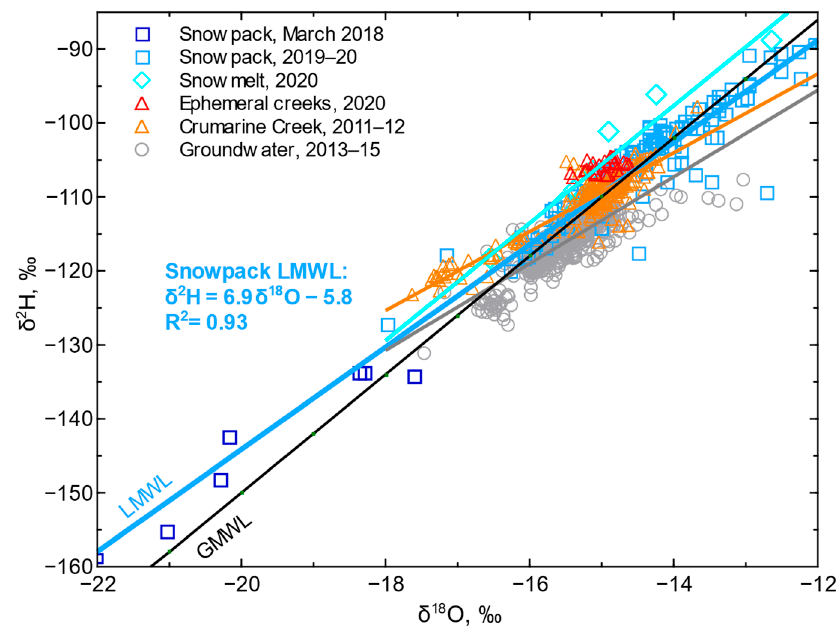
Figure 11. δ 2 H and δ 18 O for snow, snowmelt, ephemeral creeks, Crumarine Creek, and groundwater in the South Fork Palouse River Basin. The colored trendlines indicate the local meteoric water line (LMWL) for the potential source waters. The Global Meteoric Water Line (GMWL) is shown for reference.